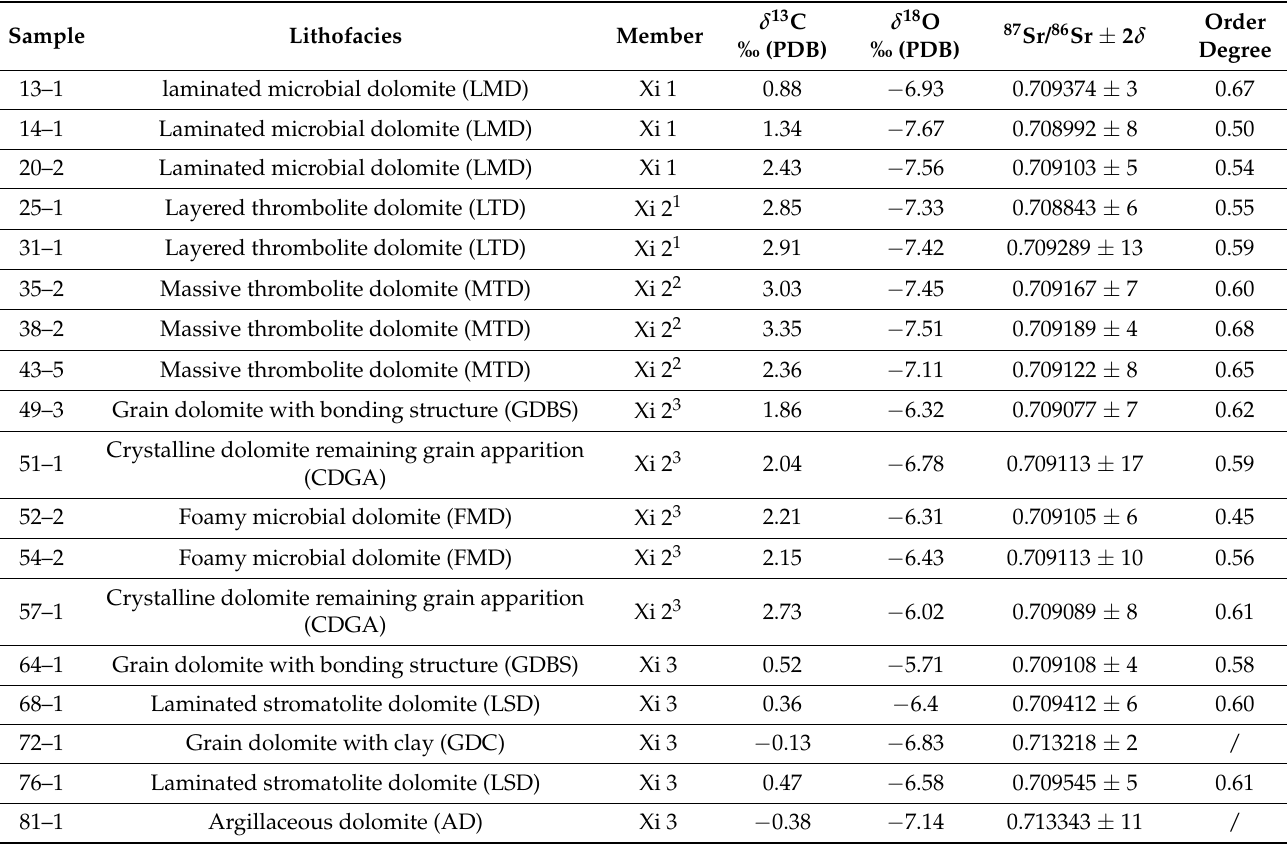
Table 1. Order degree, δ 13 C, δ 18 O and 87 Sr/ 86 Sr value of dolomite in Xiaoerblak formation.